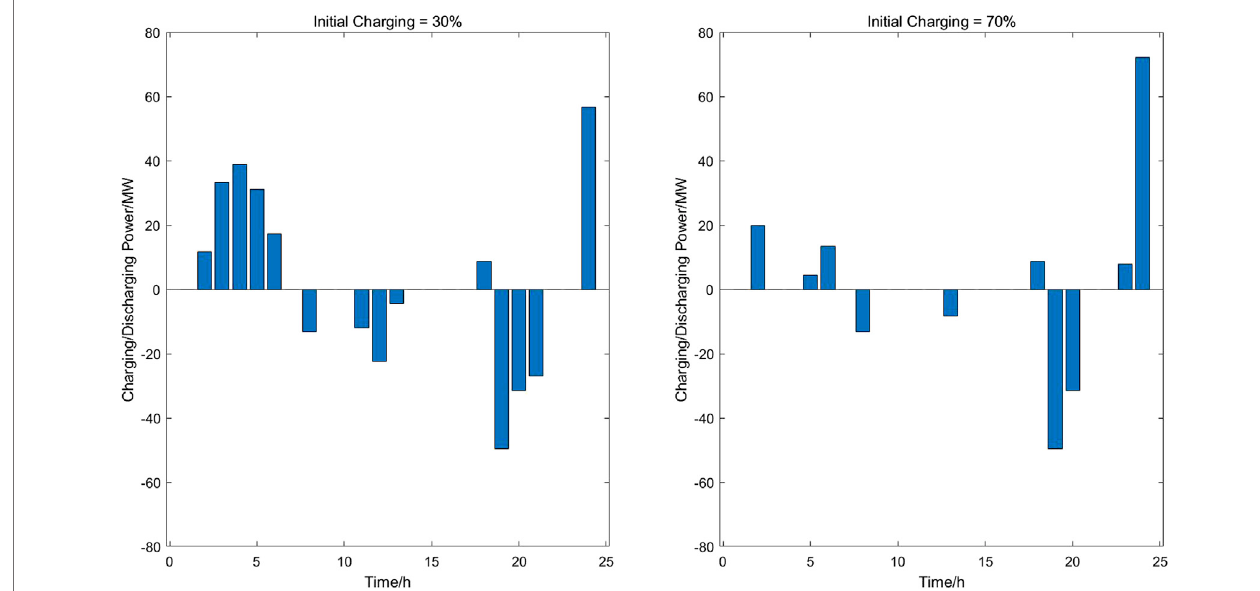
FIGURE 10 | Charging and discharging behaviors under different initial charging